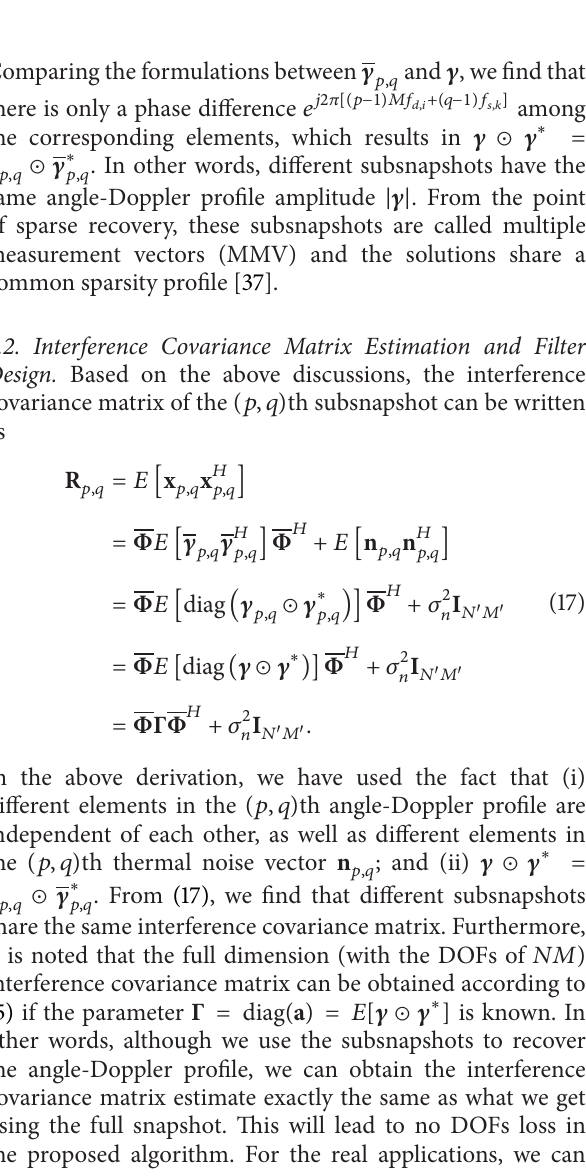
Figure 2: Generation of the subsnapshots from the space-time snapshot in the CUT using SASM